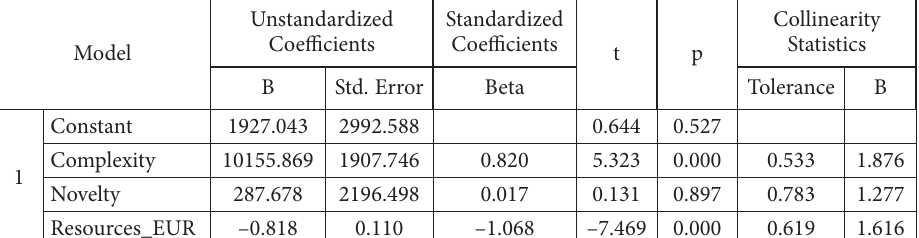
Table 6 above indicates that the regression model is of sufficient quality for prediction (the degree of freedom of the F statistic is less than 0.05). Table 7. Regression coefficient